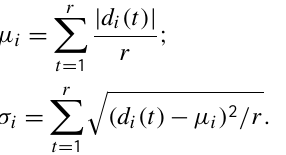
Figure 2. Scatter diagram showing the parameter sensitivity using the Morris sensitivity analysis. The x axis stands for the main effect sensitivity of a single parameter. The y axis stands for the inter- active effect sensitivity among multi-parameters. In GAMIL2, c0, rhminl, rhminh, and cmftau have high sensitivity and ke, c0_shc, and capelmt have low